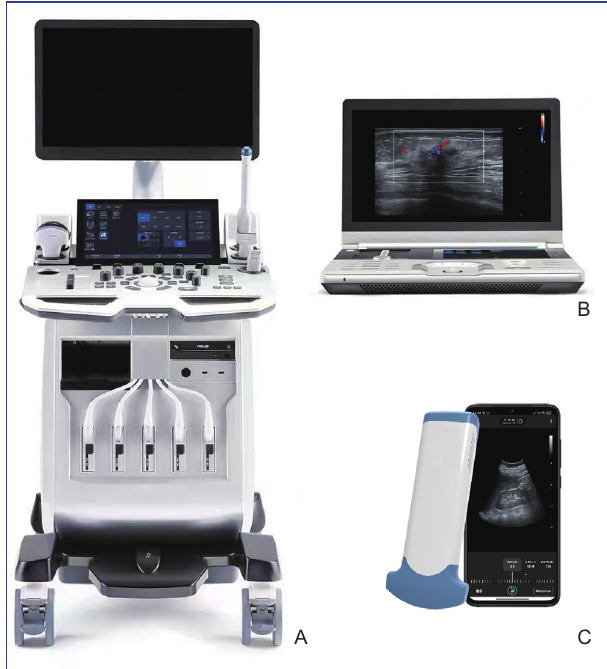
B A Figure 1 Current typical diagnostic ultrasound devices: console ultrasound device (A) and portable ultrasound device, the latter is subdivided into laptop-based (B) and pocket-sized (C).